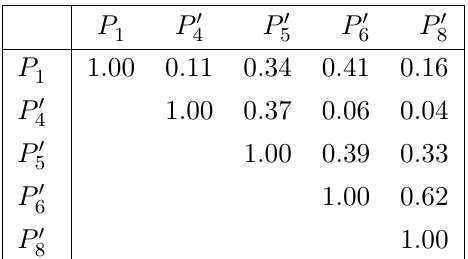
) parameters obtained for q 2 2 [4 : 0 ; 6 : 0] GeV 2 . 0